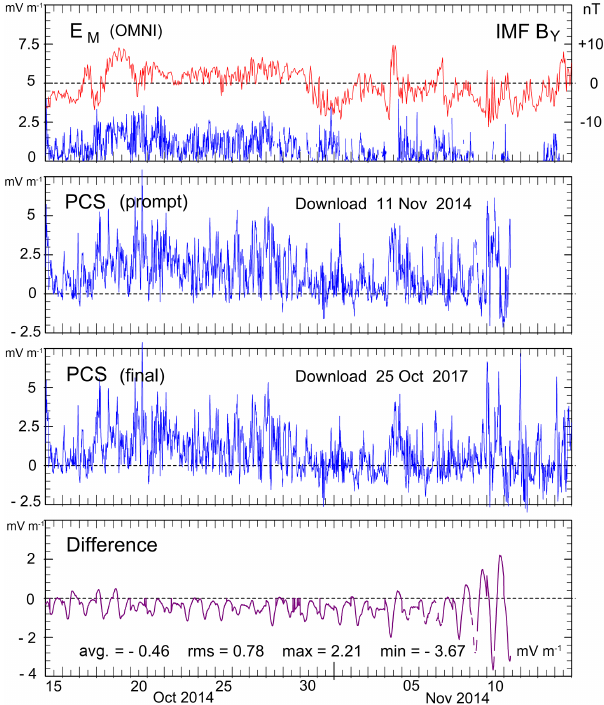
Figure 5. From top: solar wind electric field (blue line, left scale) and IMF B Y component (red line, right scale), PCS (prompt), PCS (final), and (in bottom panel) differences between final and prompt PCS values. Average, rms, and peak differences are noted. The pre- sented values are 5min averages of 1min